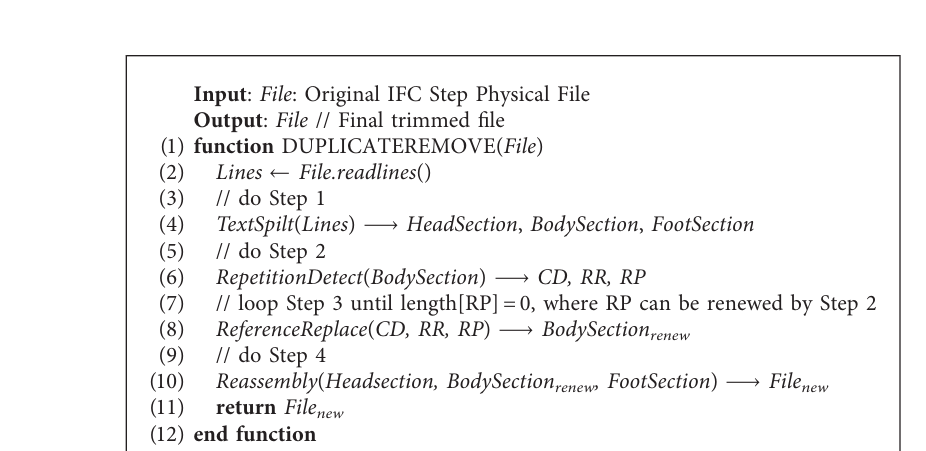
Figure 4: Methodology of this